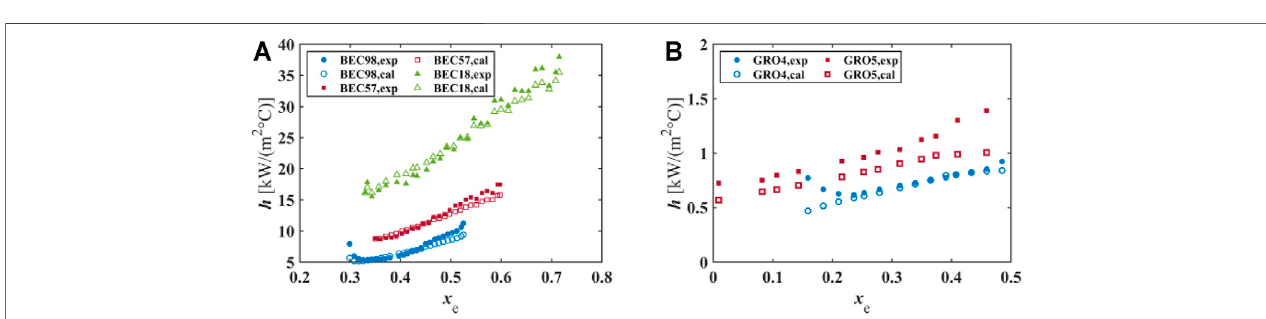
FIGURE 11 | Effect of pressure on PDO heat transfer. (A) Water experiments: G (cid:1) 2000 kg/(m 2 · s) , q (cid:1) 600 kW/m 2 . (B) CO 2 experiment: G (cid:1) 703 kg/(m 2 s) , q (cid:1) 79.9 kW/m 2